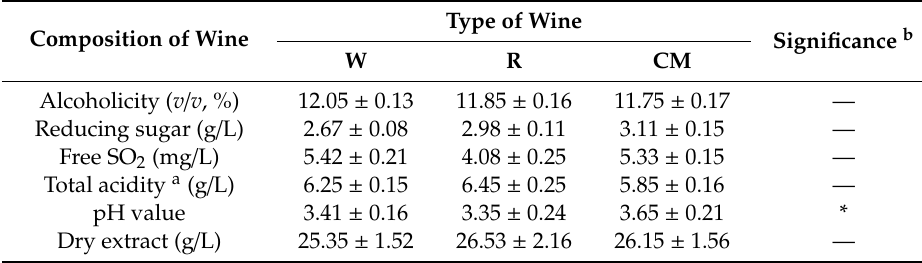
Table 1. General composition of Muscat Hamburg